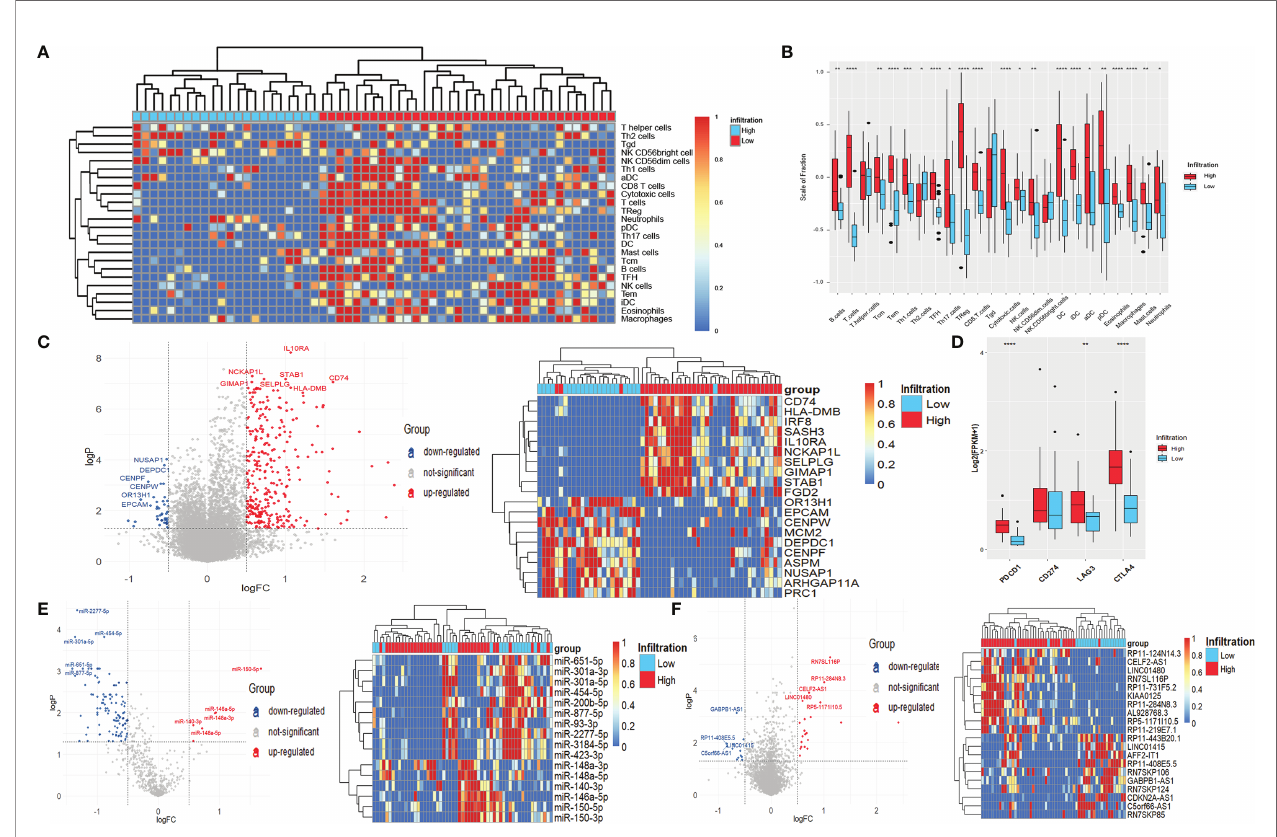
FIGURE 4 | Differentially expressed genes, miRNAs, and lncRNAs of LSCC patients with different immune-in fi ltration phenotypes in the GEO cohort. (A) Unsupervised clustering of 24 types of immune cells for 57 LSCC patients. (B) Fraction of immune cells in LSCC patients with high-in fi ltration and low-in fi ltration phenotypes. *p < 0.05; **p < 0.01; ***p < 0.001; ****p < 0.0001. (C) Volcano plot and heatmap of DEGs. (D) Expression of common targets of immune therapies. **p < 0.01; ****p < 0.0001. (E) Volcano plot and heatmap of differentially expressed miRNAs. (F) Volcano plot and heatmap of differentially expressed